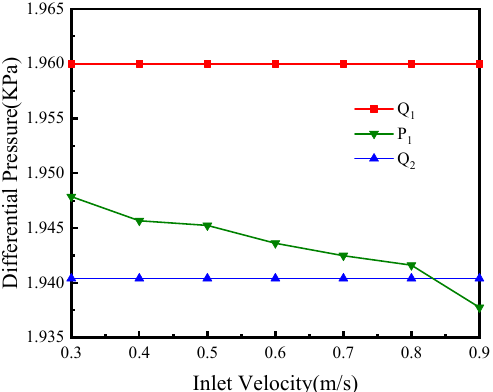
Figure 10. Chart showing the changes in the measured differential pressure (in clean water) with the inlet velocity.